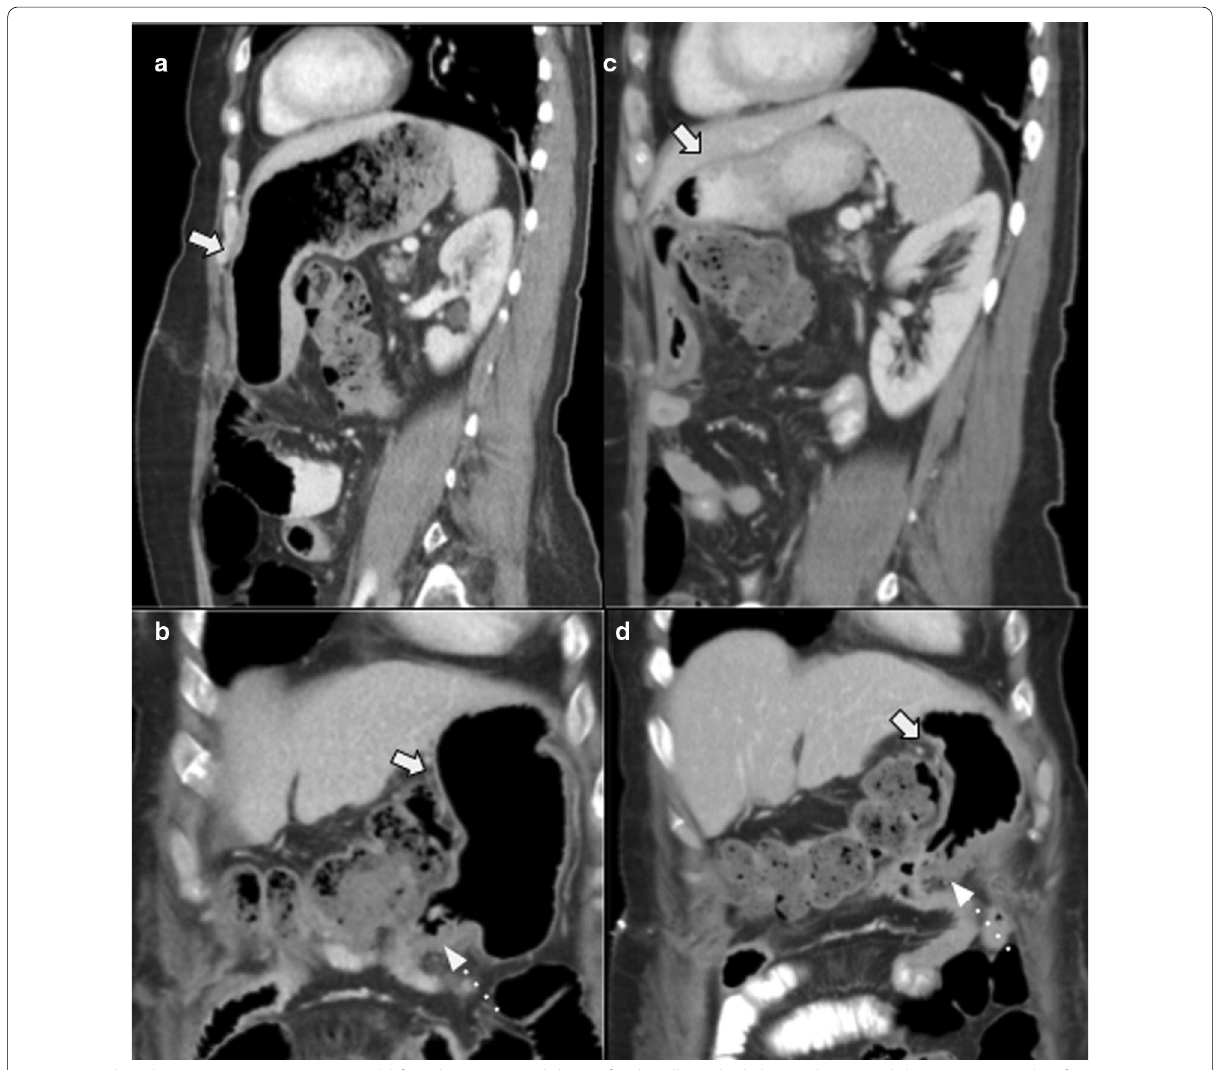
Fig. 23 Delayed gastric emptying. 57-year-old female patient inability to feed orally with abdominal pain and distension 3 weeks after pylorus-preserving pancreaticoduodenectomy. ( a , b ) CT scans during acute event revealed marked stomach distention (big arrows). ( c , d ) Normal volume regression after medical treatment (big arrows). Duodenojejunostomy is also noted (dotted arrows in b and d